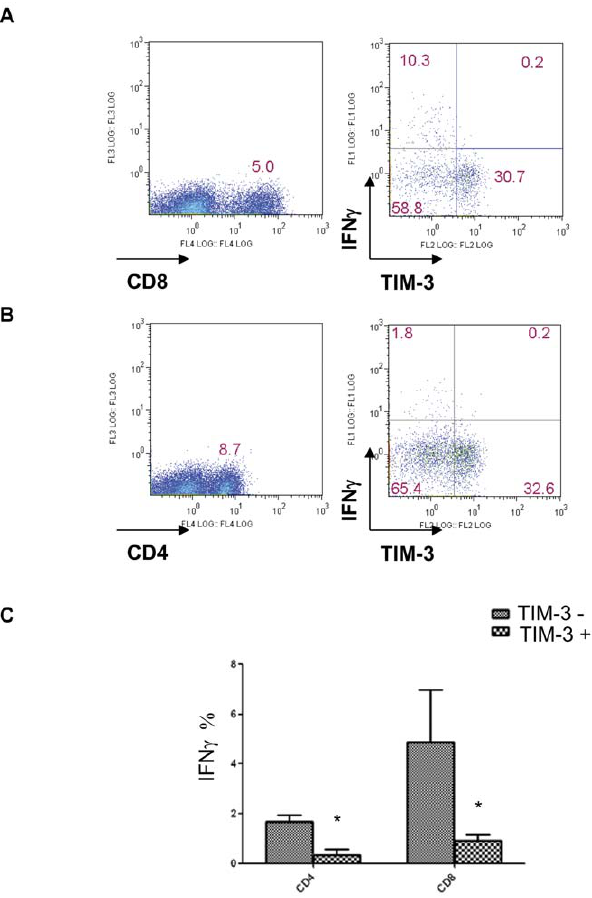
Figure 2. IFN- c production by TIM-3 + and TIM-3 2 T cells in lung cancer tissues. TILs were harvested from lung cancer tissue. Cells